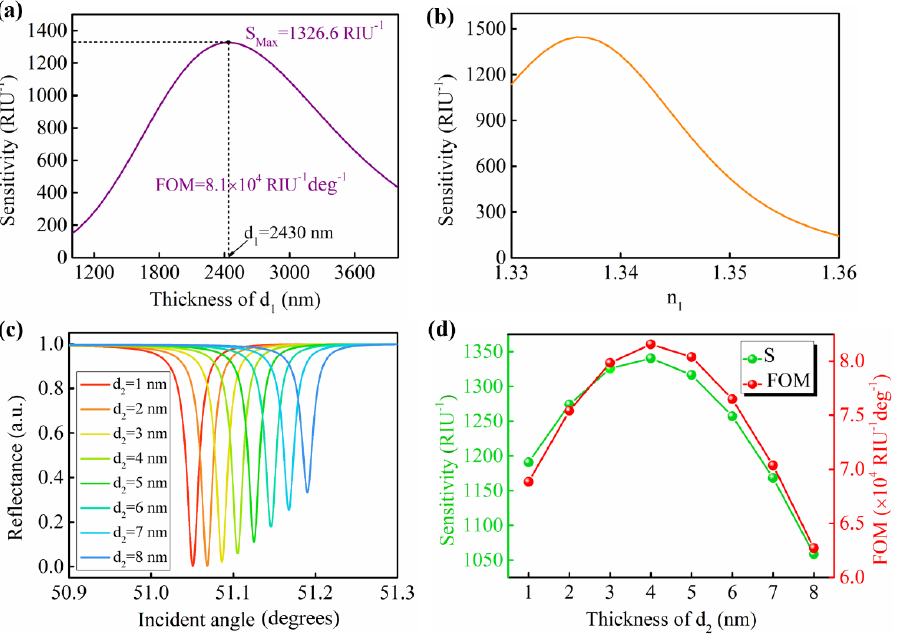
Figure 4. ( a ) Variation of the intensity sensitivity when the thickness of the low − RI dielectric film (d 1 ) ranged from 1000 nm to 3800 nm for the proposed GW − LRSPR sensor. ( b ) The intensity sensitivity as a function of the RI of the low − RI dielectric film (n 1 ) at d 1 = 2430 nm. ( c ) The reflectance curves of the proposed GW − LRSPR sensor at different thicknesses of the low − RI GW layer (d 2 ) when d 1 = 2430 nm and n 1 = 1.34. ( d ) The intensity sensitivity and FOM of the GW − LRSPR sensor at different d 2 values.